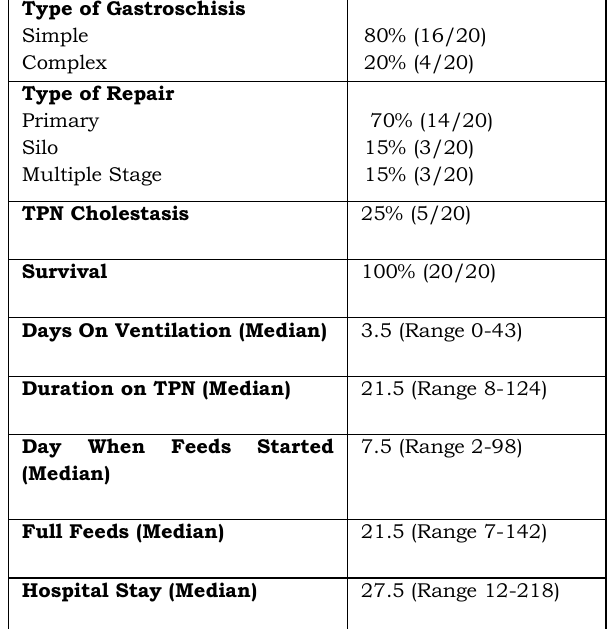
Table 2: Treatment details of the gastroschisis group Type of Gastroschisis